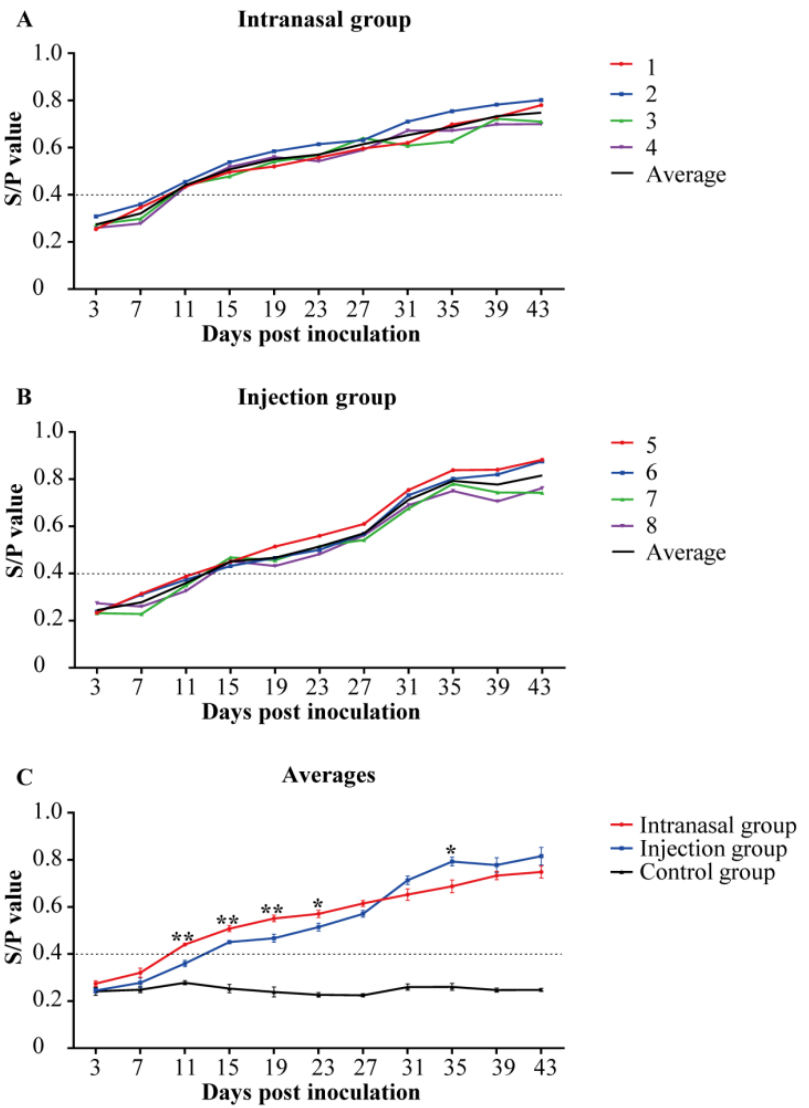
Figure 3. Anti-PRRSVserum IgG levels. The anti-PRRSV serum IgG levels were quantified using ELISA in piglets ( n = 4 in each group) to assess the anti-PRRSV antibody response. Serum samples collected at 0 dpi were served as the negative control. The cut-off for positivity was 0.4. Piglets in the control group were IgG-negative throughout the study. ( A , B ): Colored lines represent the individual animals, and black lines represent the mean value of each group. Numbers (1–9) represent the individual pig numbers. ( A ) Anti-PRRSV serum IgG levels in the intranasal group. ( B ) Anti-PRRSV serum IgG levels in the injection group. ( C ) The averages of serum IgG levels within each group. The graph illustrates the mean SEM. Statistical differences were determined using the ± t -test (* p < 0.05; ** p < 0.01). Comparisons were between the Intranasal and the Injection